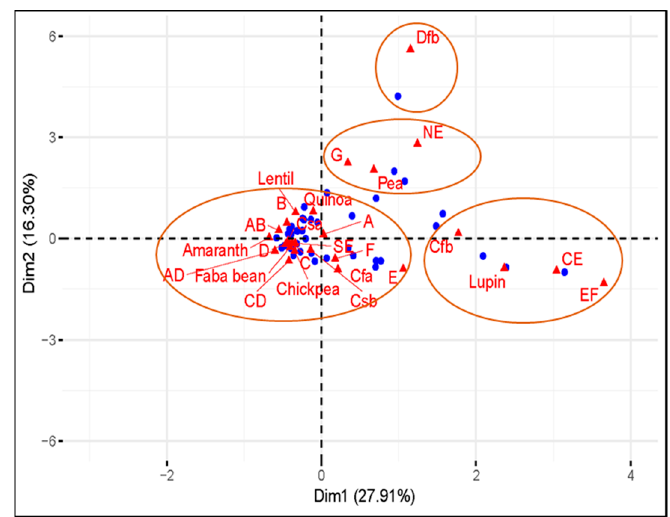
Figure 7. Multiple correspondence analysis plot of protein crops, European environments, and agronomic management factors induced by the first two dimensions components. Protein crops (quinoa, amaranth, pea, faba bean, lupin, chickpea, and lentil), European environments (geographic and climatic zones), and agronomic management (different agronomic practices) are plotted on the two first axes. Rows (observations) are represented by blue points and columns (categorical variables) by red triangles. Orange ellipses indicate different clusters analyzed.